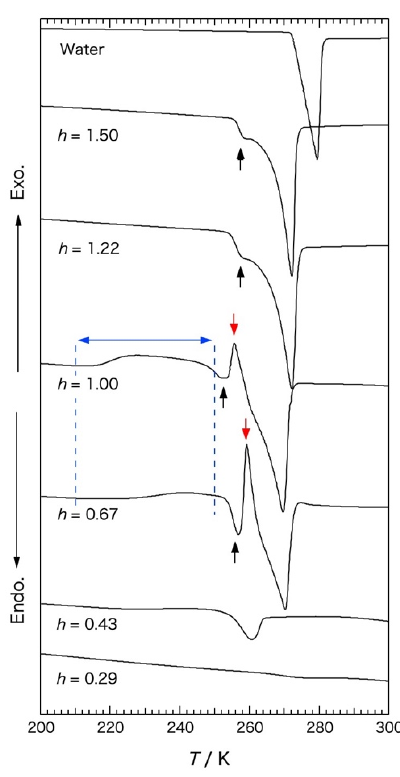
Figure 1. DTA rewarming traces obtained with Sephadex ® G25 gels ( h = 0.29–1.50), where h = g H 2 O/g dry G25. Heating rate was 2 K min − 1 and precooling rate was 5 K min − 1 . The vertical scale was set arbitrarily in each thermogram. ↑ : small endotherm, ↓ : exotherm due to ice crystallization, ↔ : temperature range of exotherm.